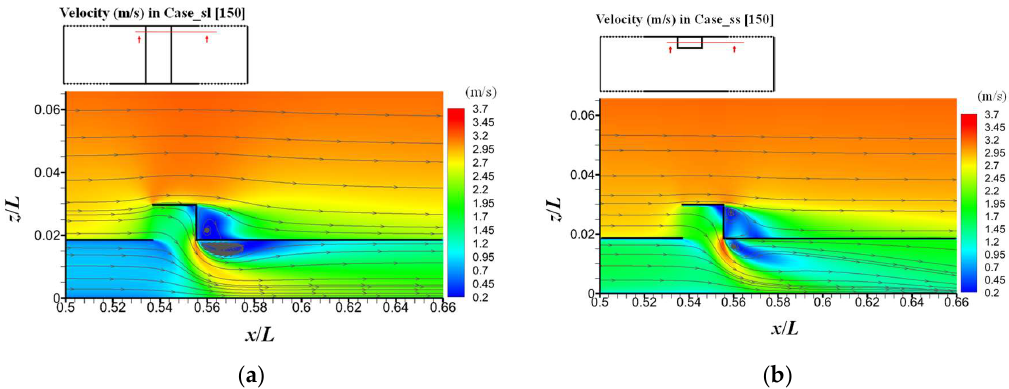
Figure 6. Velocity magnitude with streamlines in ( a ) Case_sl [150] and ( b ) Case_ss [150] on a vertical cross section at the central left-pedestrian region.